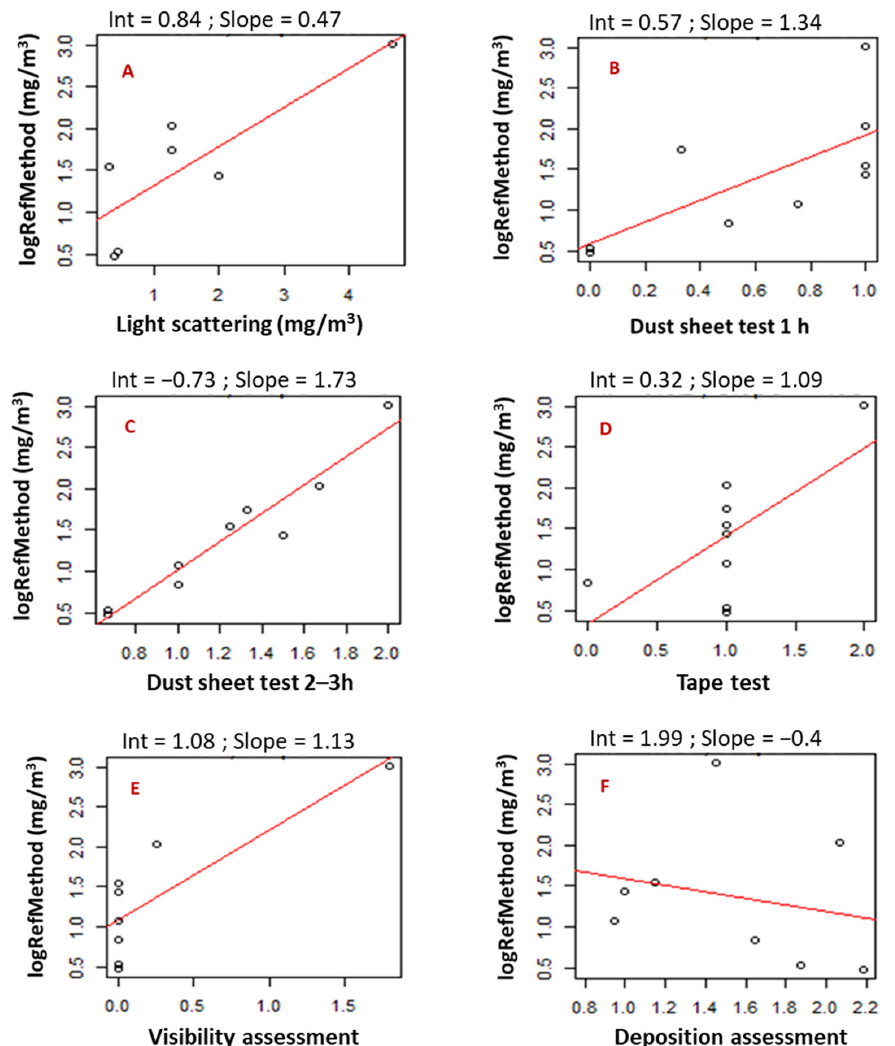
Figure 3. The regression lines (in red) for the log-transformed dust concentration from the reference method as a function of the dust level obtained using the methods under examination: ( A ) light scattering measurement, ( B ) dust sheet test 1 h, ( C ) dust sheet test 2–3 h, ( D ) tape test, ( E ) visibility